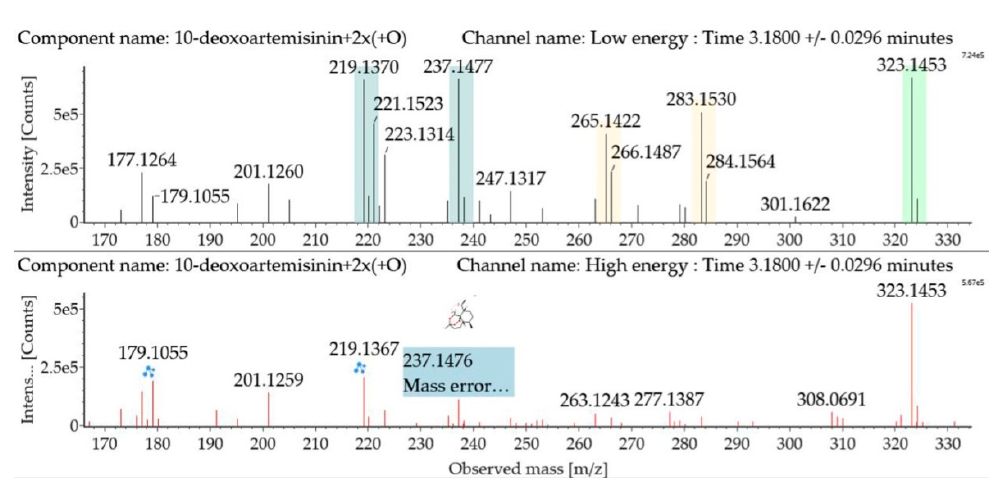
Figure 5. UPLC-ESI-Q-TOF-MS E spectra and the fragmentation diagram of dihydroxylated 10-deoxoartemisinin.